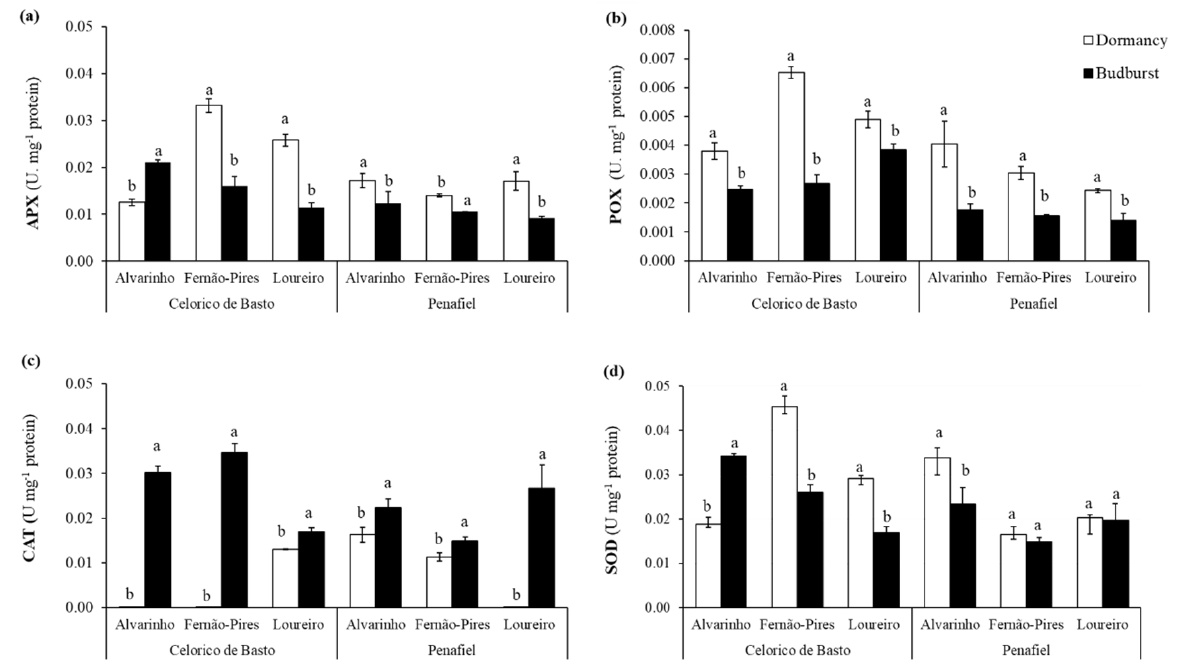
Figure 3. Enzymatic activity of ascorbate peroxidase (APX) ( a ), peroxidase (POX) ( b ), catalase (CAT) ( c ), superoxide dismutase (SOD) ( d ) in two phenological stages (dormancy and budburst) in Alvarinho, Fern ã o-Pires, and Loureiro buds from Celorico de Basto and Penafiel sites. The columns represent the mean values and the bars the respective standard error of three replicates. Different letters indicate significant differences between phenological stages ( p <